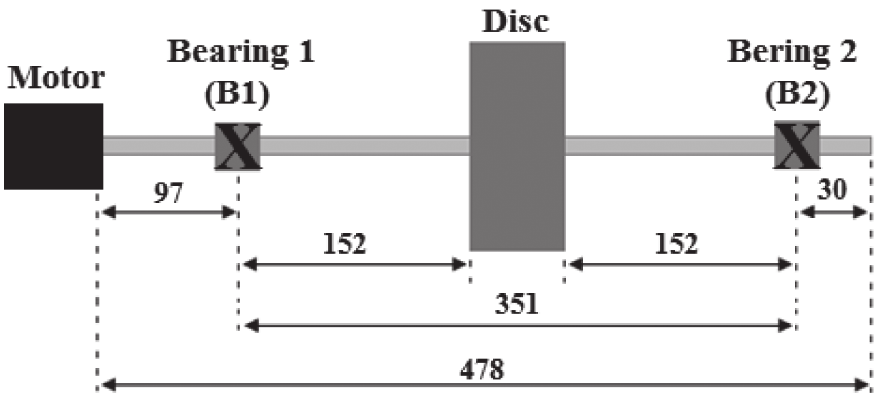
Figure 8 - Sketch of the rotor used in the test rig (dimensions in